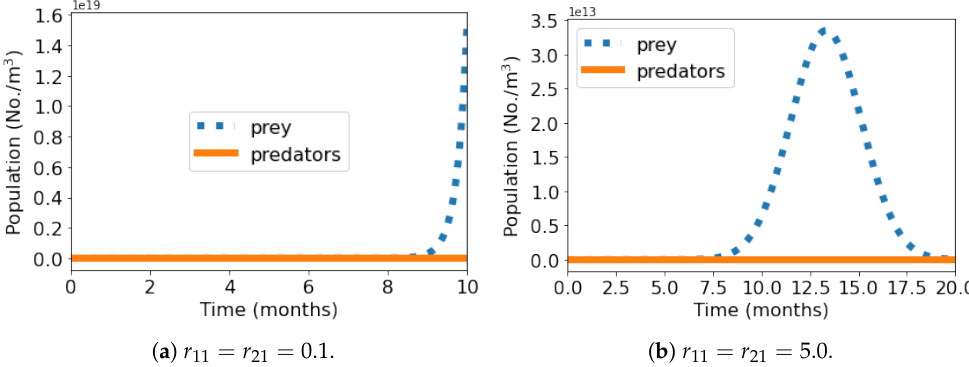
Figure 3. Short-term population dynamics of the predator–prey for α (cid:48) = 0. Predator and prey have the same response strength to MP particles, i.e., ∆ = r 11 / r 21 = 1.0. Abscissa measures time in months and ordinate measures the number of organisms (No./m 3 ). The populations of prey ( x 1 ) and predator ( x 2 ) are represented by the blue dotted line and the orange continuous one,